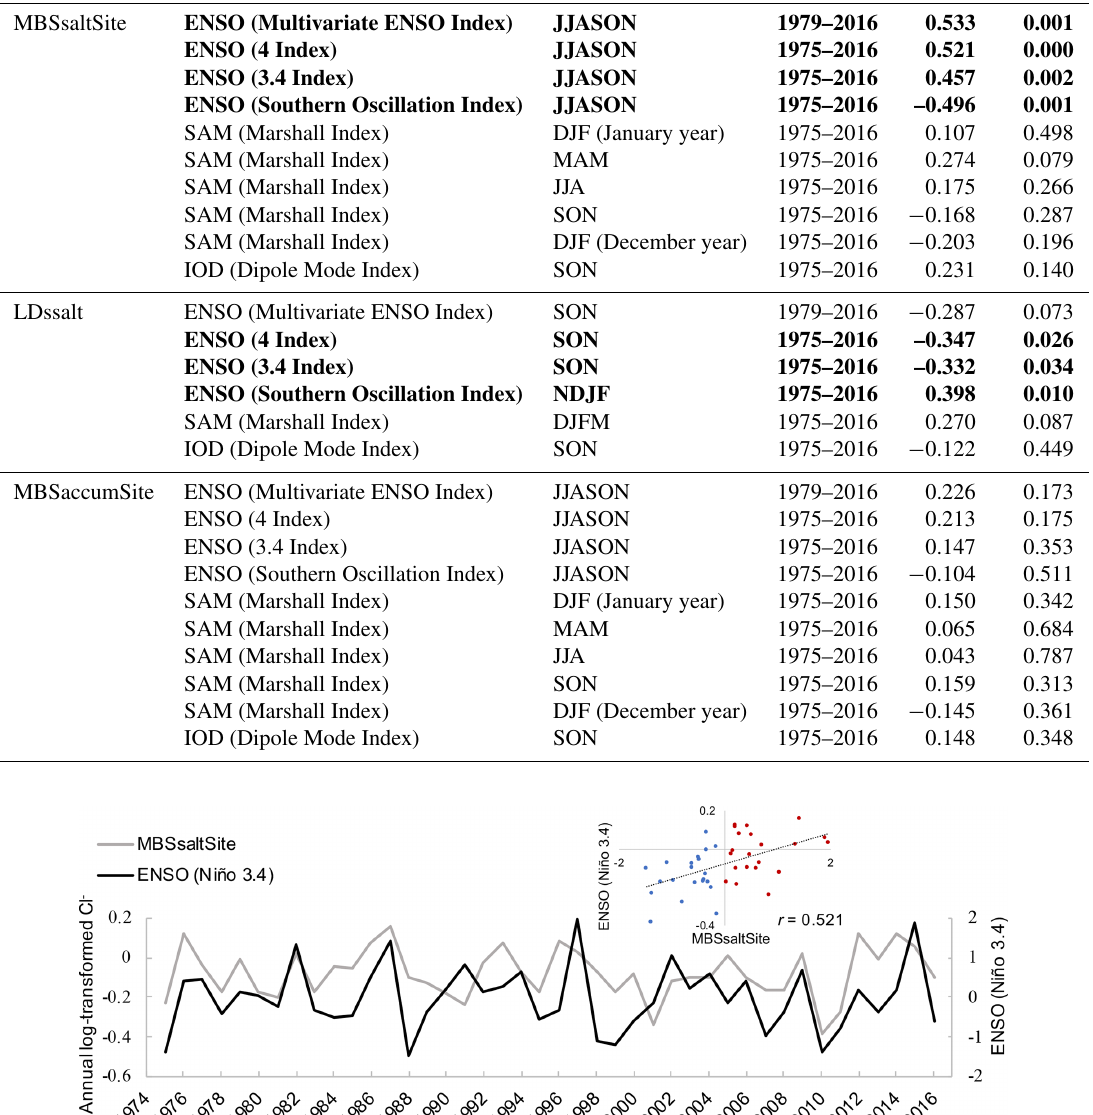
Figure 6. Time series of the annual detrended, log-transformed sea salt concentrations for the Mount Brown South site average (MBSsaltSite) and the detrended (June–November) El Niño–Southern Oscillation region SST anomalies (ENSO, Niño 3.4 Index). The embedded scatter plot shows the relationship between the two time series differentiated by positive (red dots) and negative (blue dots) Niño 3.4 region SST anomalies based on the period